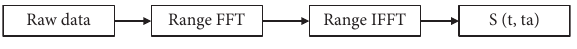
Figure 1: Flow chart of eliminating residual video phase